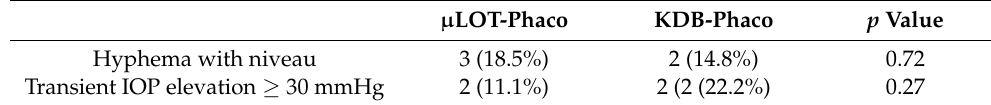
Table 4. Postoperative